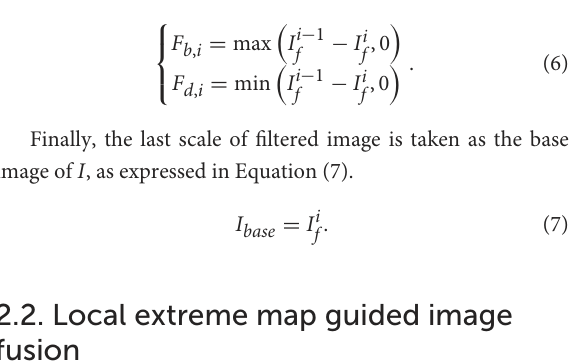
two continuously filtered images according to Equation